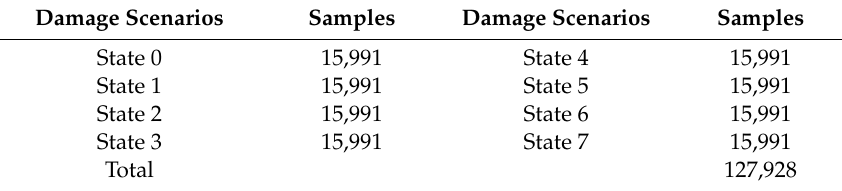
Table 2. Samples of dataset D.